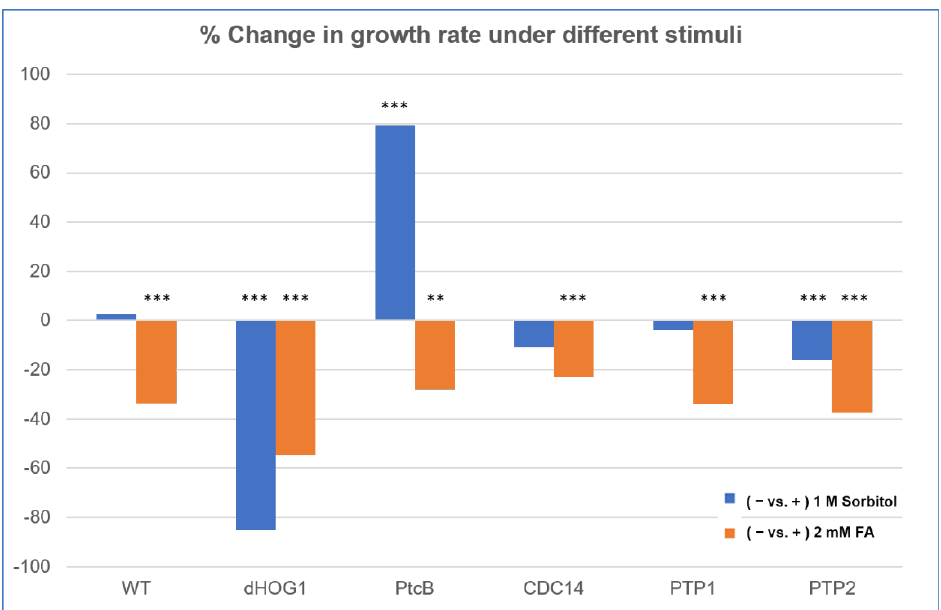
Figure 7. Comparison of FA and sorbitol’s effects on the different strains. The data from Figure 6 are replotted as ratios. CM agar plates with or without sorbitol (− or + 1 M sorbitol) or CM with 0.15% v/v DMSO with or without FA (− or + 2 mM FA) were compared. The t -test p -values are marked as follows: p -value < 0.05—**; p -value < 0.01—***.